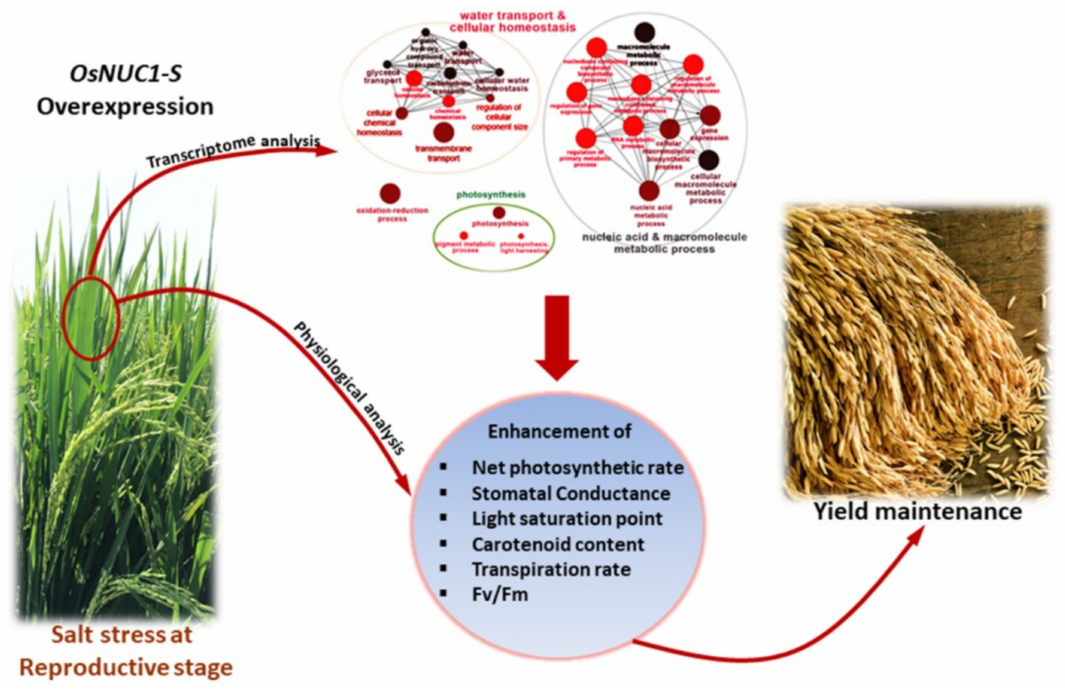
Figure 11. The scheme summarized the role of OsNUC1-S overexpression contributing to salt tolerance in